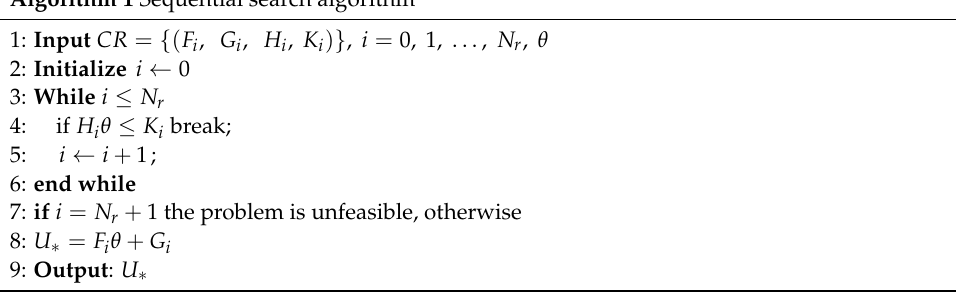
Algorithm 1 Sequential search